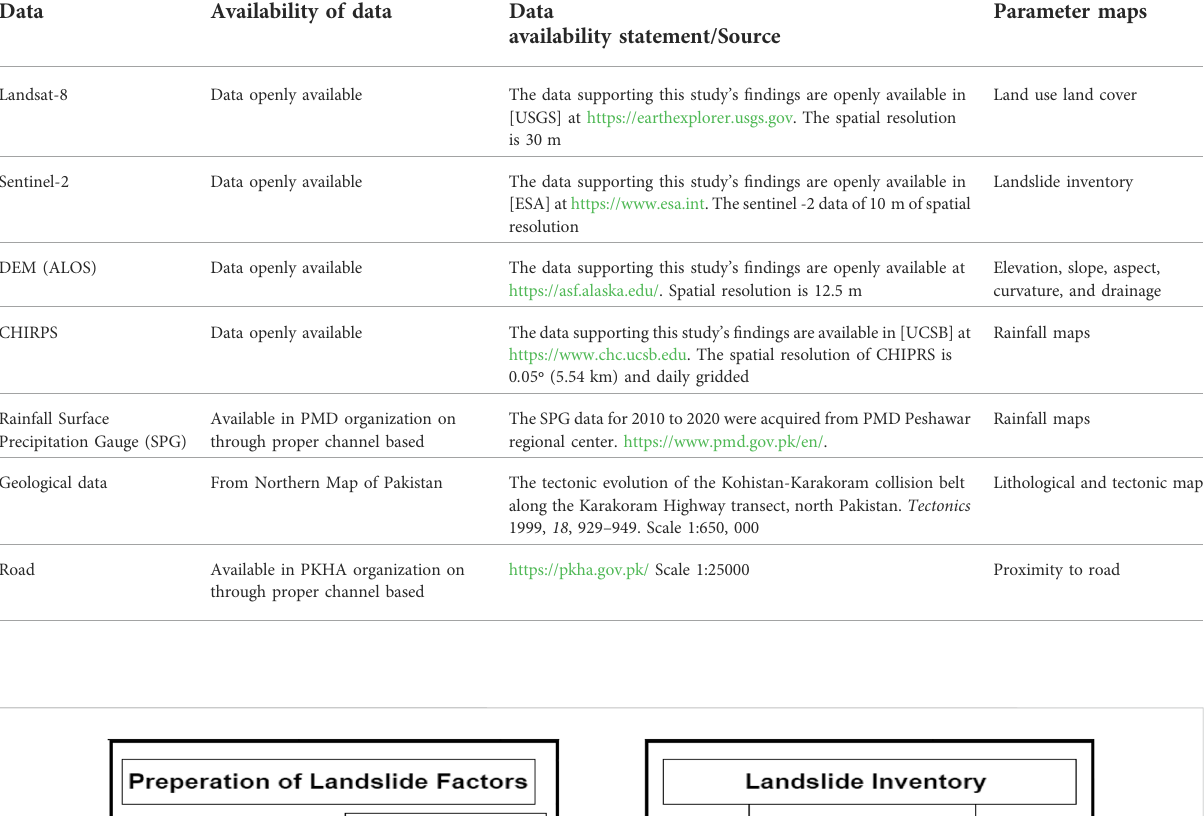
TABLE 1 Detailed RS and ground data availability, statement, source, and purpose.